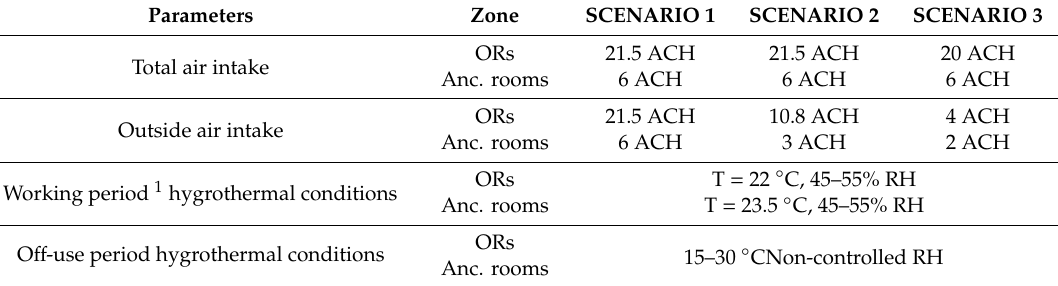
Table 3. Main simulated ventilation parameters in the di ff erent